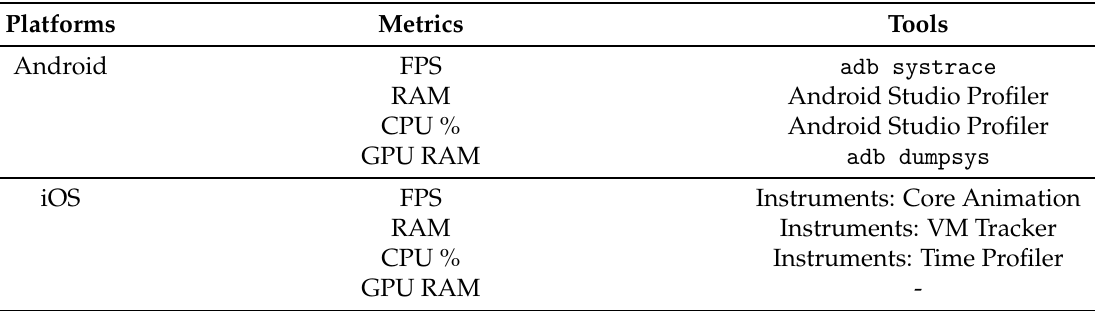
Table 3. Tools Associated with